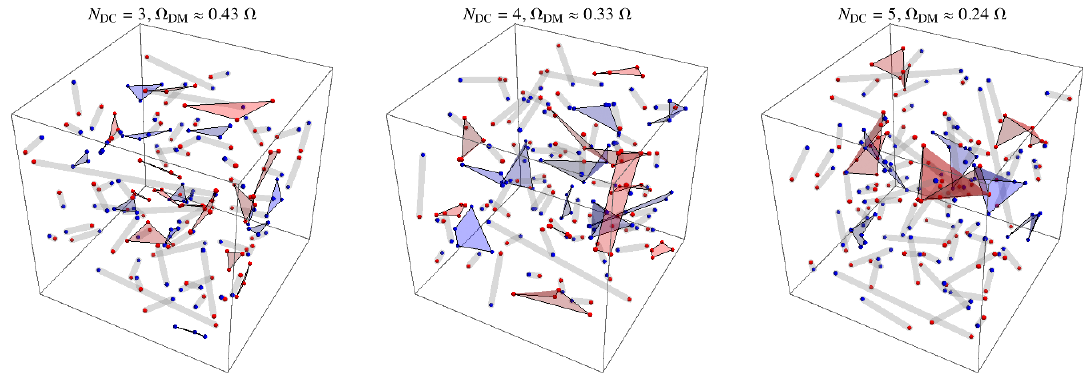
Figure 5 . Examples of dark condensation for N DC = 3 (left), 4 (middle) and 5 (right). Dark quarks (anti-quarks (cid:22) ) are denoted as red (blue) dots, placed at random positions. We assume that each Q Q (cid:22) DM particle combines with its dark nearest neighbour, forming either unstable dark mesons Q Q N DC dark baryons (red regions) and (cid:22) N DC dark anti-baryons (blue regions). (gray lines) or stable Q Q